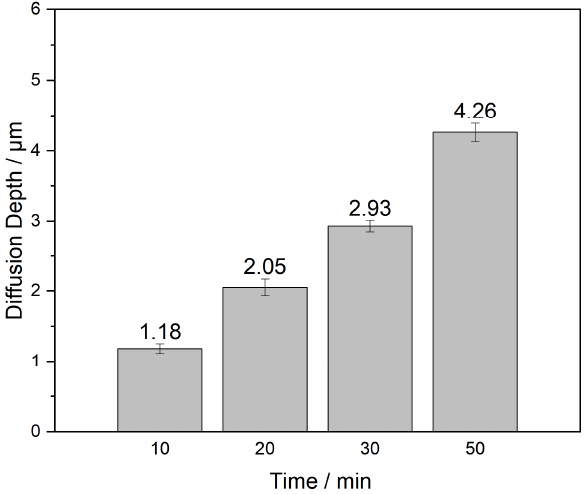
Figure 12. The thickness of the vanadium deposition layer on the cathode plate at different electro- deposition times.